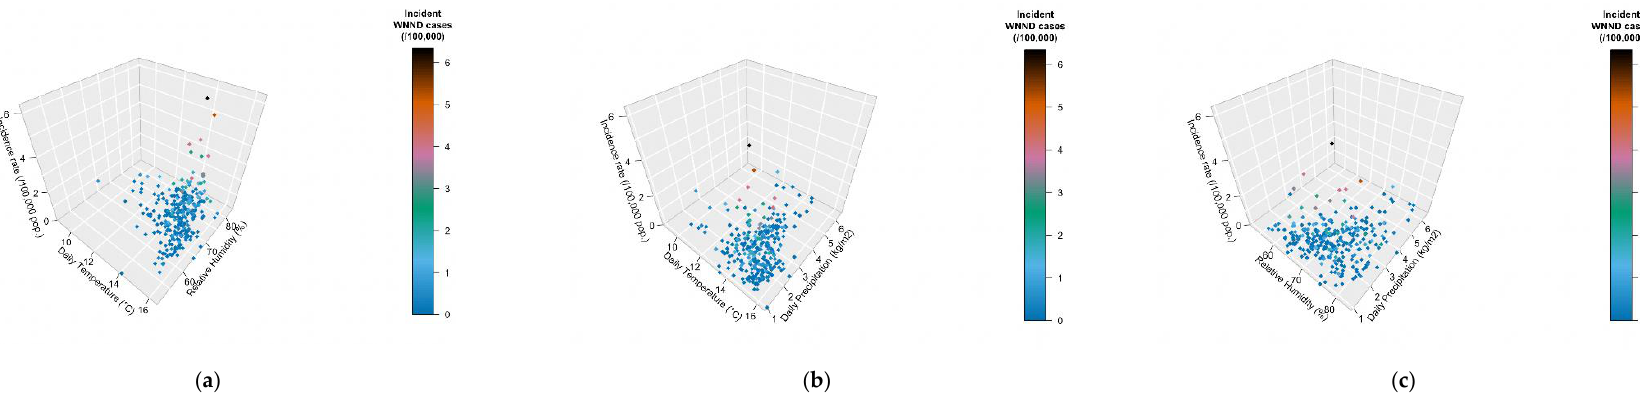
Figure 7. Three-dimensional representation of the incidence rate ( z -axis), by meteorological factors, represented by daily temperature (( a ), x -axis; ( b ), x -axis), relative humidity (( a ), y -axis; ( c ), x -axis), and daily precipitation rate (( b , c ), y -axis).